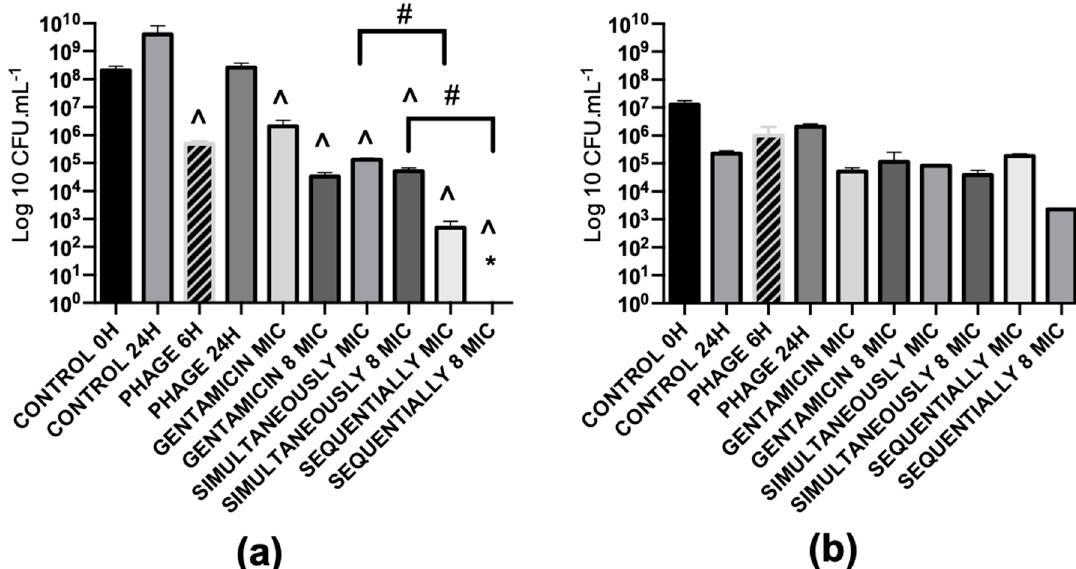
Figure 7. Treatment of 48 h dual-species biofilm. ( a) P. aeruginosa number of viable cells. ( b) S. aureus number of viable cells. A prefix PHAGE indicates EPA1 in MOI 1, 6 H and 24 H indicates treatment time period for 6 and 24 h, MIC indicates the dose of antibiotics with 1 × MIC value of P. aeruginosa , 8 MIC indicates the dose of antibiotics with 8 × MIC value of P. aeruginosa, PHAGE + antibiotic indicates simultaneous treatment and PHAGE 6 H + antibiotics indicates phage was added first then antibiotic was added with 6 h delay. * Under detection limit ( < 10 2 ). ( ˆ ) Statistical di ff erences between the control and treated biofilms. (#) Statistical di ff erences between the simultaneously and sequentially treated biofilms. Statistical di ff erences were determined by two-way repeated-measures analysis of variance (ANOVA) with a Tukey’s multiple comparison test.